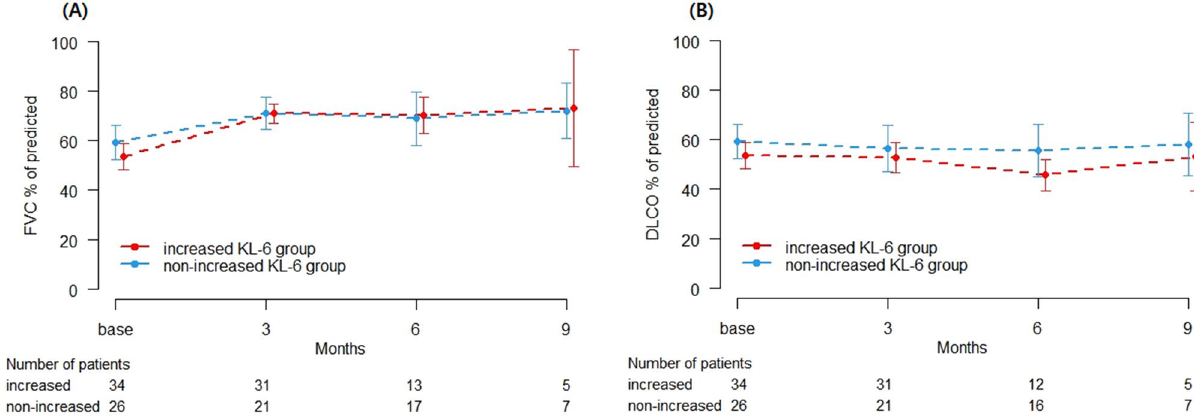
Figure 3. Serial lung function change according to the KL-6 level by serial change groups. ( A ) FVC, ( B ) DLco. KL-6: Krebs von den Lungen-6, FVC: Forced vital capacity, DLco: Diffusing capacity of the lung for carbon